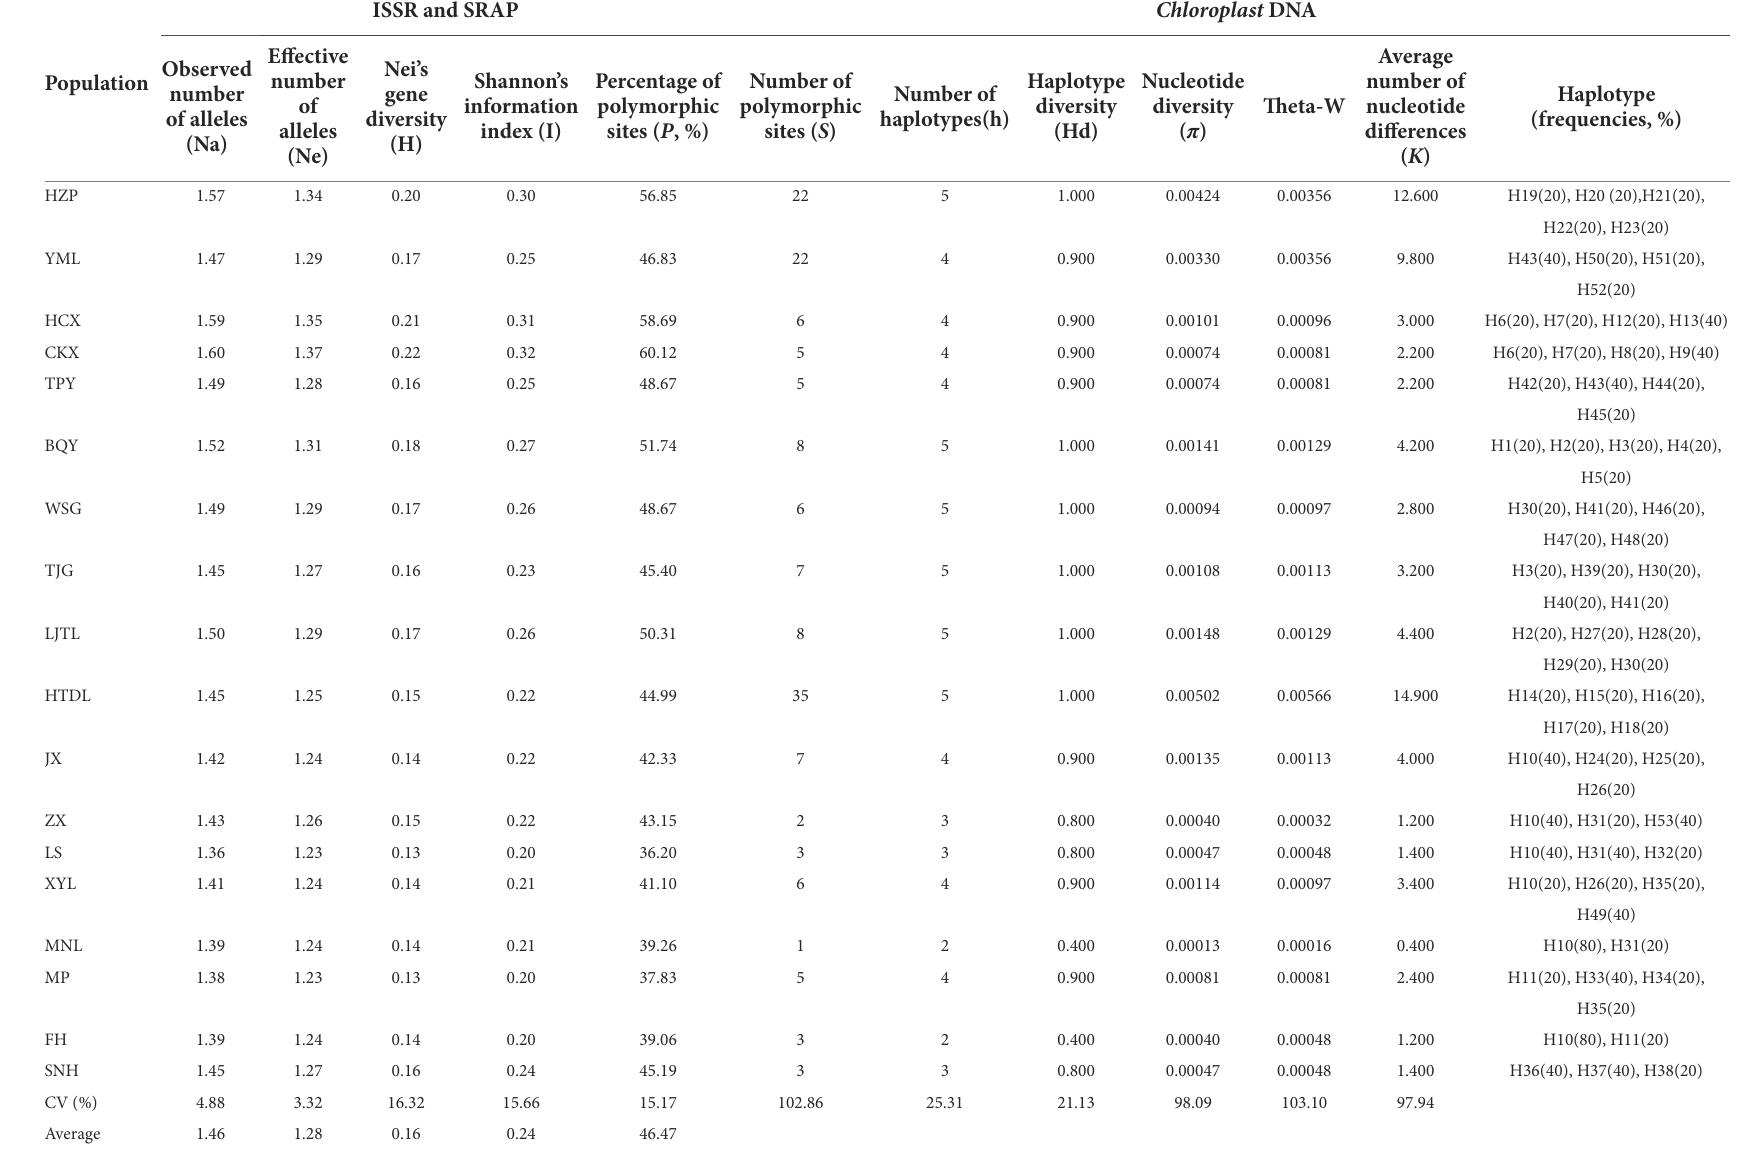
TABLE 1 Genetic diversity of the 18 tested populations of tea-oil Camellia resources in Sect. Oleifera based on ISSR, SRAP and chloroplast sequence markers.